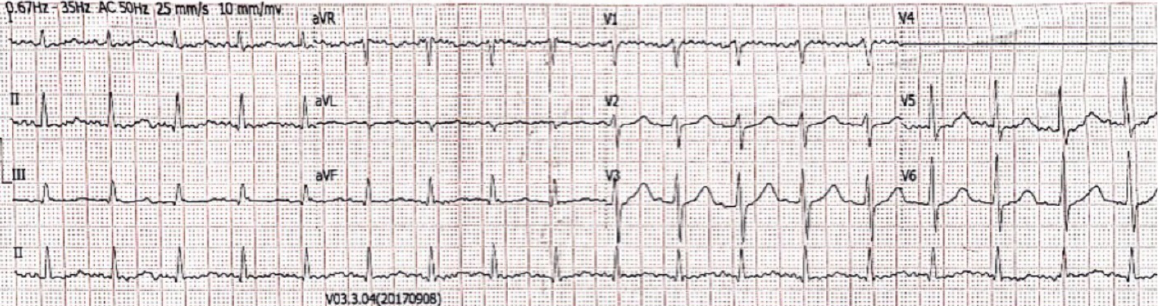
Figure 3. Following administration of anti-allergic treatment, a new electrocardiogram showed si- nus tachycardia with complete resolution of ST-segment elevation and first-degree atrioventricular block.